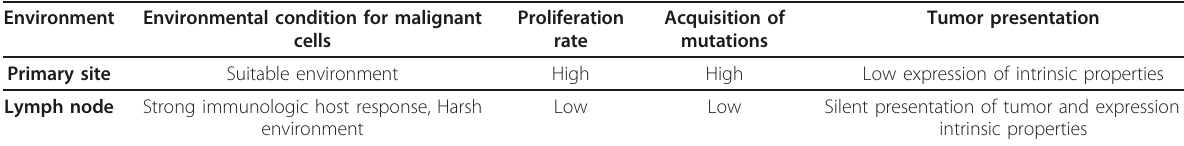
Table 2 The effect of environment on malignant cells Environment